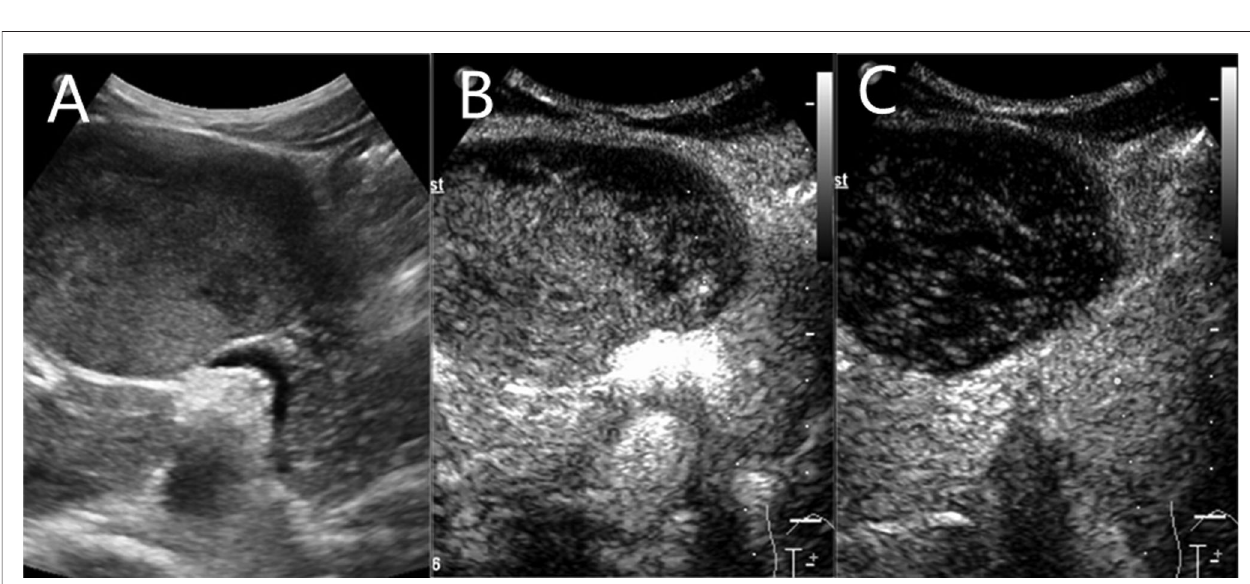
FIGURE 1 | Contrast-enhanced magnetic resonance (MR) of a mass on the pancreatic neck-body. ( A ) T1W Cross-sections MR in arterial phase. ( B ) T1W Cross- sections MR in portal phase. ( C ) T2W Axial MR in arterial phase.